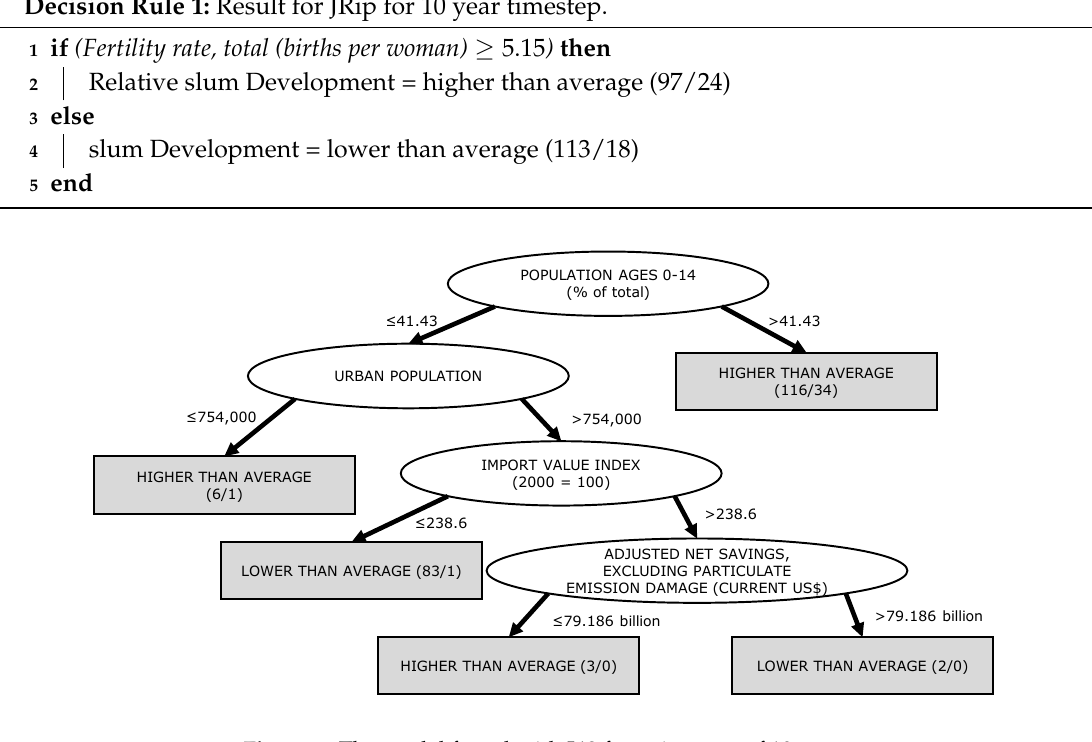
Figure 2. The model found with J48 for a timestep of 10 years.